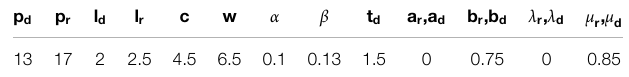
TABLE 1 | Assignment of the model